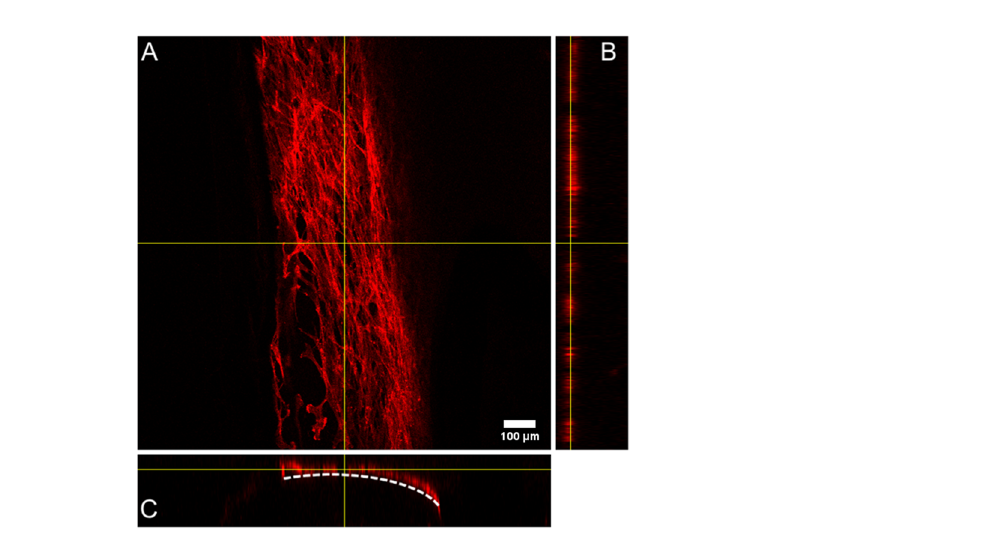
Figure 5. Representative confocal microscopy images of MSC growing on PLA 3D-printed scaffold surface after 7 days of cultivation for ( A ) X–Y plane; ( B ) Y–Z plane; ( C ) X–Z plane. Cells were visualized with Alexa 647-conjugated phalloidin. The dashed line represents the surface of the scaffold. Direct imaging of PLA/HA 3D-printed scaffold was not possible due to their high intrinsic